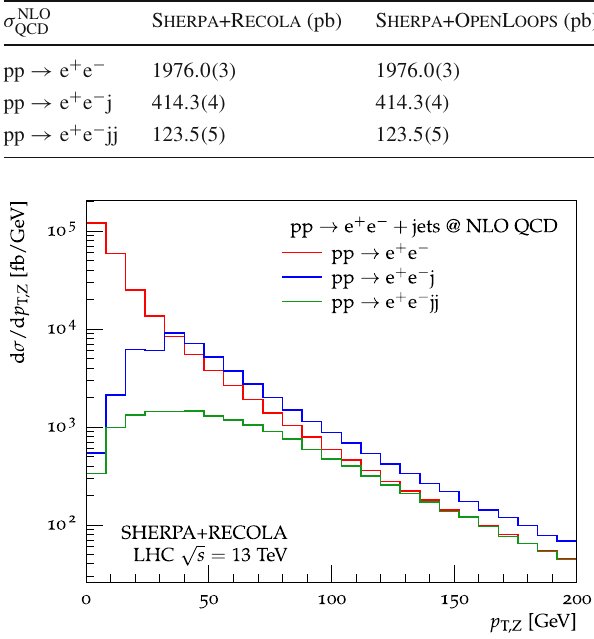
Table 3 Integrated cross sections calculated for pp → e + e − + jets at NLO QCD with the Sherpa + Recola interface compared against Sherpa +O pen L oops